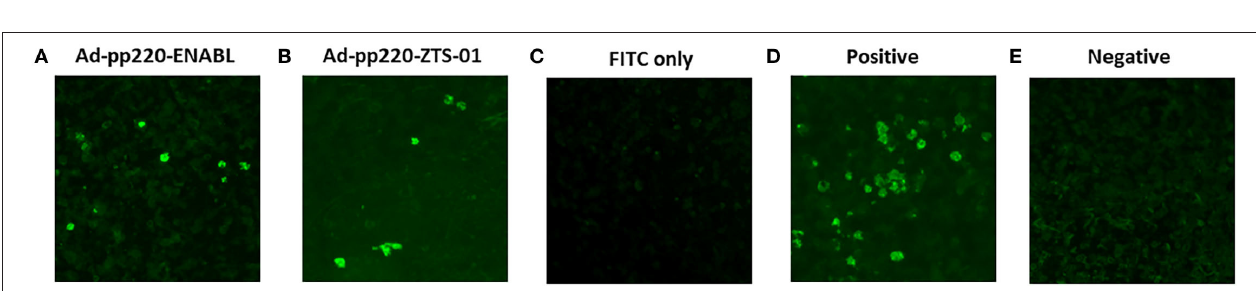
FIGURE 5 | Antibody titers for pp220 antigens. IgG end-point titers were determined by ELISA for p5-34-14-37, p150-I, and p150-II in sera from week 1 post-boost and in ASFV-specific convalescent porcine serum. Mean IgG titers for the groups are denoted by bars, whereas IgG titers in the convalescent serum are denoted by the pink star.